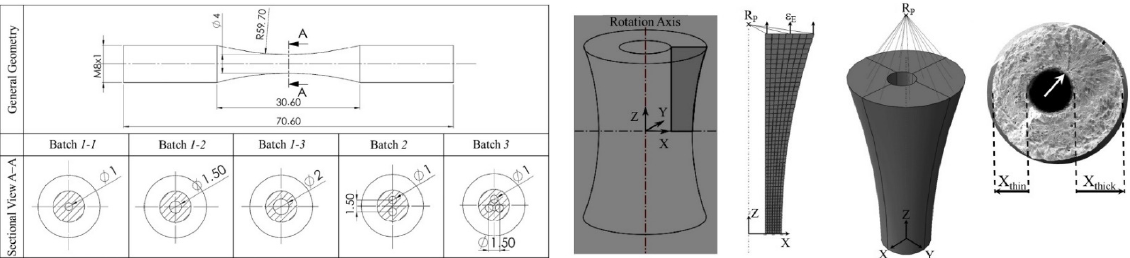
Figure 8. The geometry of fatigue samples from the study by Günther et al. machined from raw cylinders and definition of different batches with all dimensions in mm. Reprinted with permission from ref. [118]. 2018, Elsevier Ltd.